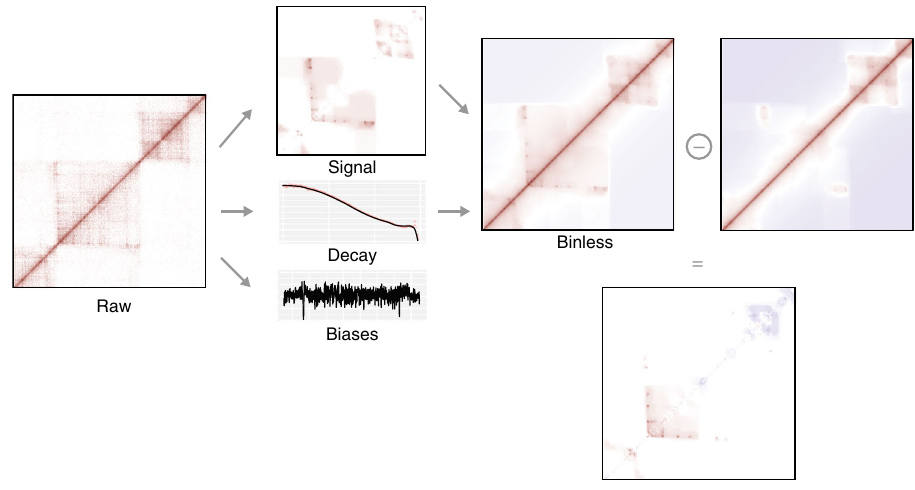
Fig. 1 Main estimates computed by Binless. From the raw data, Binless estimates genomic and decay biases, as well as an additional signal (example on the TBX3 locus, see Sup. Fig. 9). This binless signal matrix reports contributions that are signi fi cantly different from what can be expected from genomic and decay biases alone. Its unit is a minimum fold change with respect to the background. Any thresholding operation should be performed on this matrix. The binless matrix is the combination of signal and decay estimates, and is useful for visualization. If another dataset was normalized simultaneously, a binless difference matrix can be computed. Similar to the binless signal matrix, its unit is a minimum fold change from one dataset to another. Only differences which cannot be imputed to noise alone are